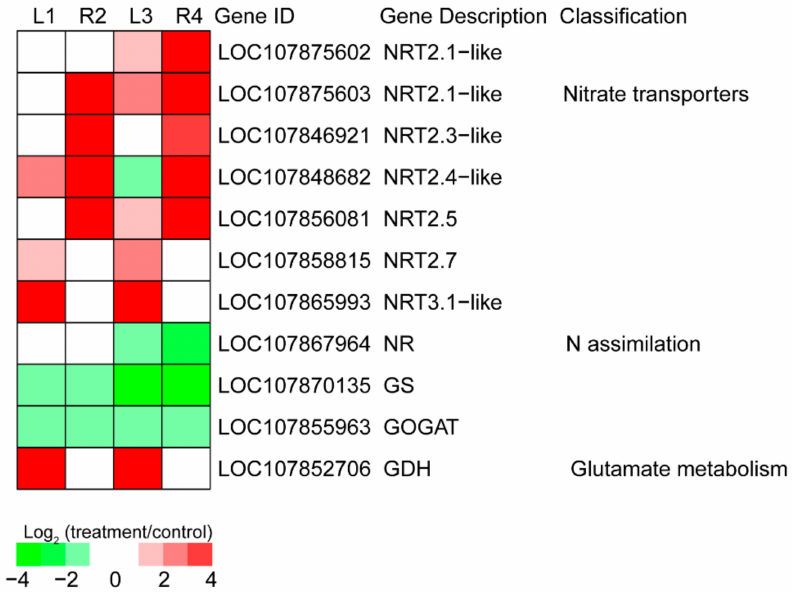
Figure 5. Heatmap of the DEGs involved in N metabolism. L1, TCL1 vs. TTL3; R2, TCR2 vs. TTR4; L3, TCL5 vs. TTL7; R4, TCR6 vs. TTR8.